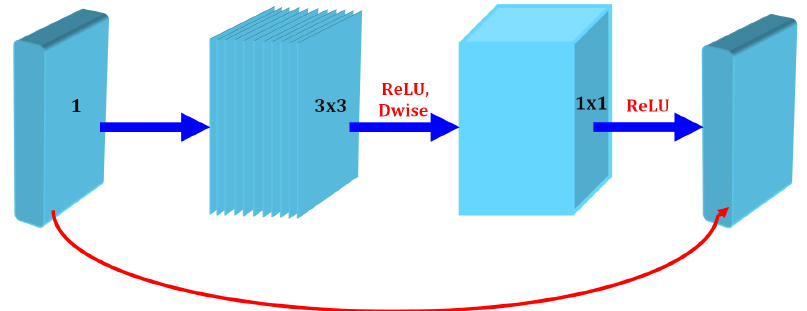
Figure 5. Inverted Residual